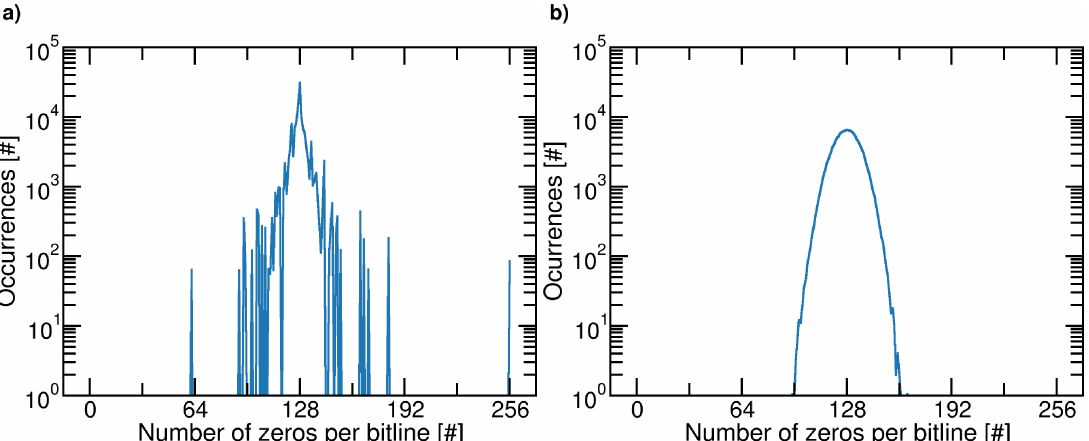
Figure 5. Distributions (occurrences) of the zeros probability in a bitline. Analysis has been performed considering a 32-bit ALFSR on a memory array of N P = 256 pages and N B = 2 17 cells. Case ( a ): Seeds derived from a mathematical manipulation of the page address; case ( b ): seeds generated